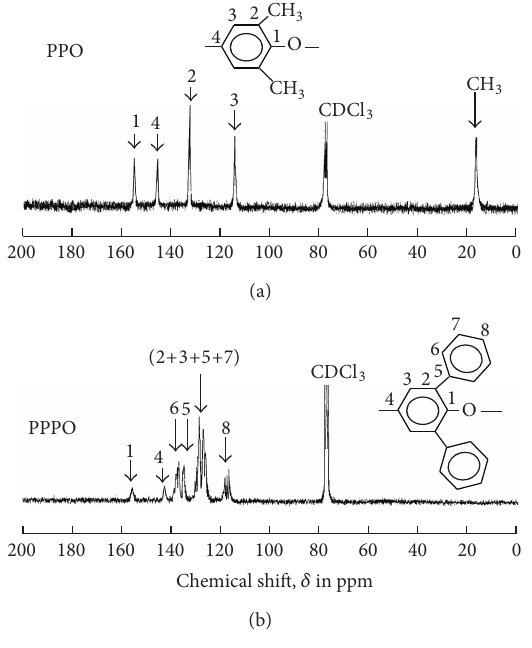
F 3: GPC chromatogram of PPO and PPPO.